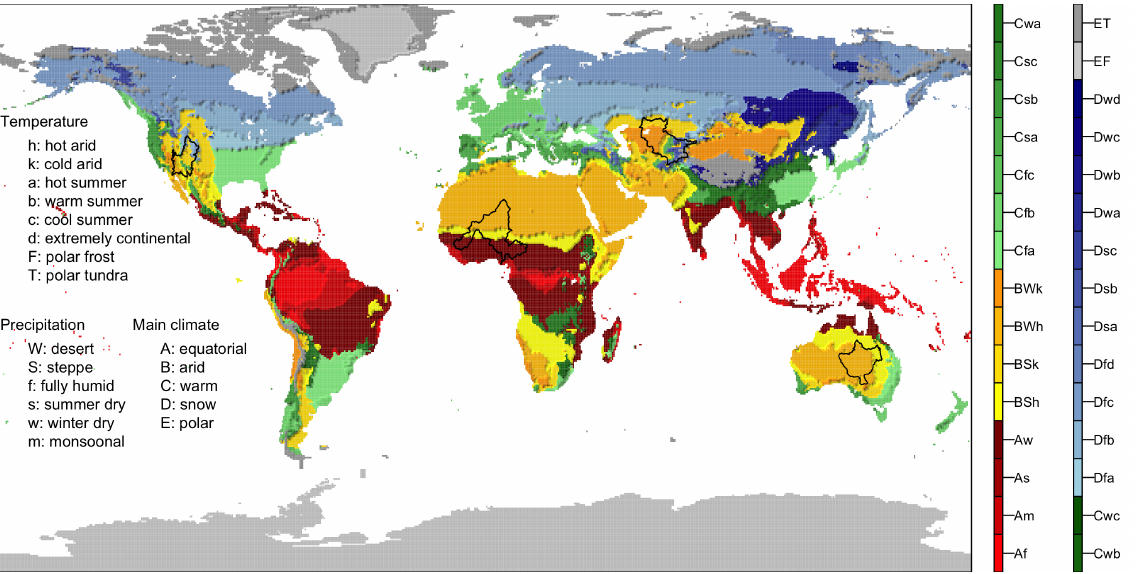
Figure 1. Selected study basins used within the analysis. Criteria for the selection of basins included predominantly arid climate (more than 50% areal coverage with any of the arid Köppen climates: BWk, BWh, BSk, or BSh), size, geographical location, and amplitude and trends in the water storage